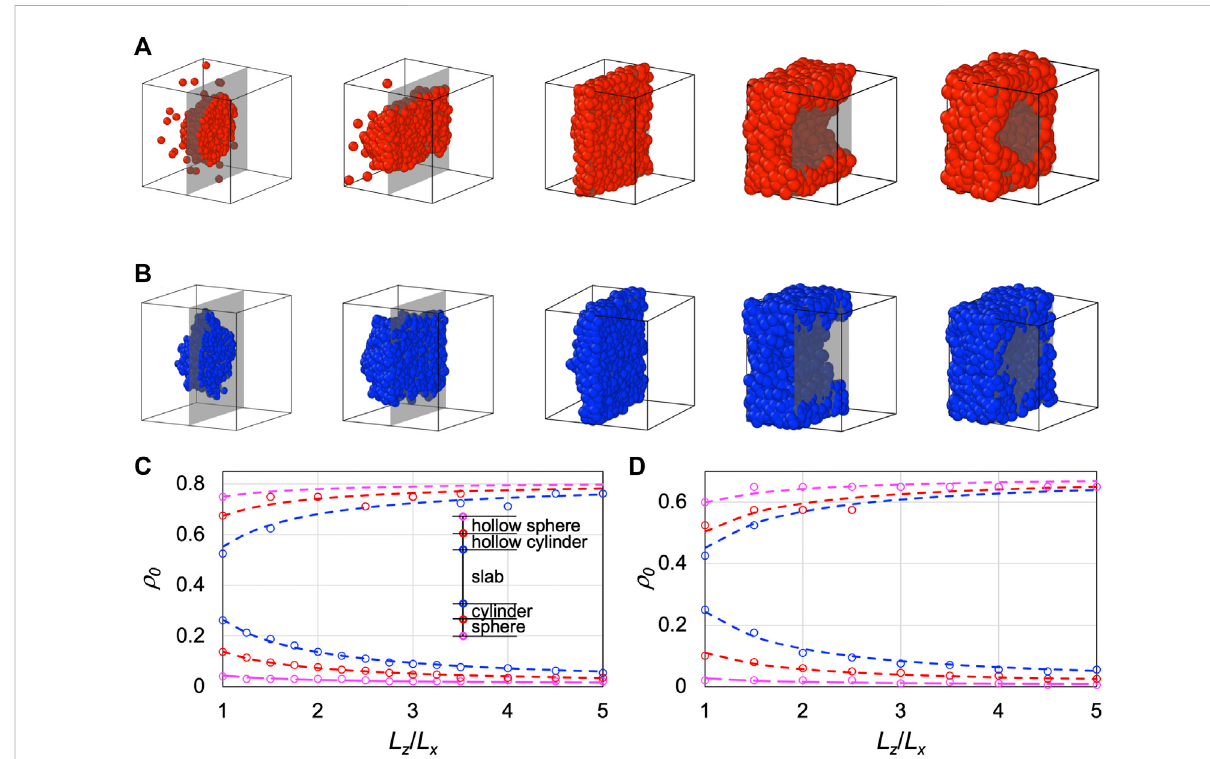
FIGURE 2 Morphologies of the dense phases of LJ particles and LJ chains over a range of initial densities inside the spinodal. (A) Morphologies for an LJ particle system of N = 1,000 particles in a cubic box at T = 0.65. The dense phase appears as a sphere, cylinder, slab, hollow cylinder, and hollow sphere at ρ 0 = 0.1, 0.2, 0.3, 0.6, and 0.7 respectively. The initial densities were changed by varying the box side lengths, which are shown here not to scale. At each density, the cubic box is cut by a plane (rendered as gray when the background is empty), and only the half behind the cut is displayed. (B) CorrespondingresultsforanLJchainsystem(10010-beadchains)at T =1.7and ρ 0 =0.1,0.2,0.3,0.5,and0.6. (C) Boundariesbetween differentmorphologies forLJparticlesinrectangular boxes withdifferent L z / L x ratios. Thedensity ranges for differentmorphologiesare illustrated in the inset. L x = 10 and T = 0.65. (D) Corresponding results for an LJ chain system at L x = 13 and T =